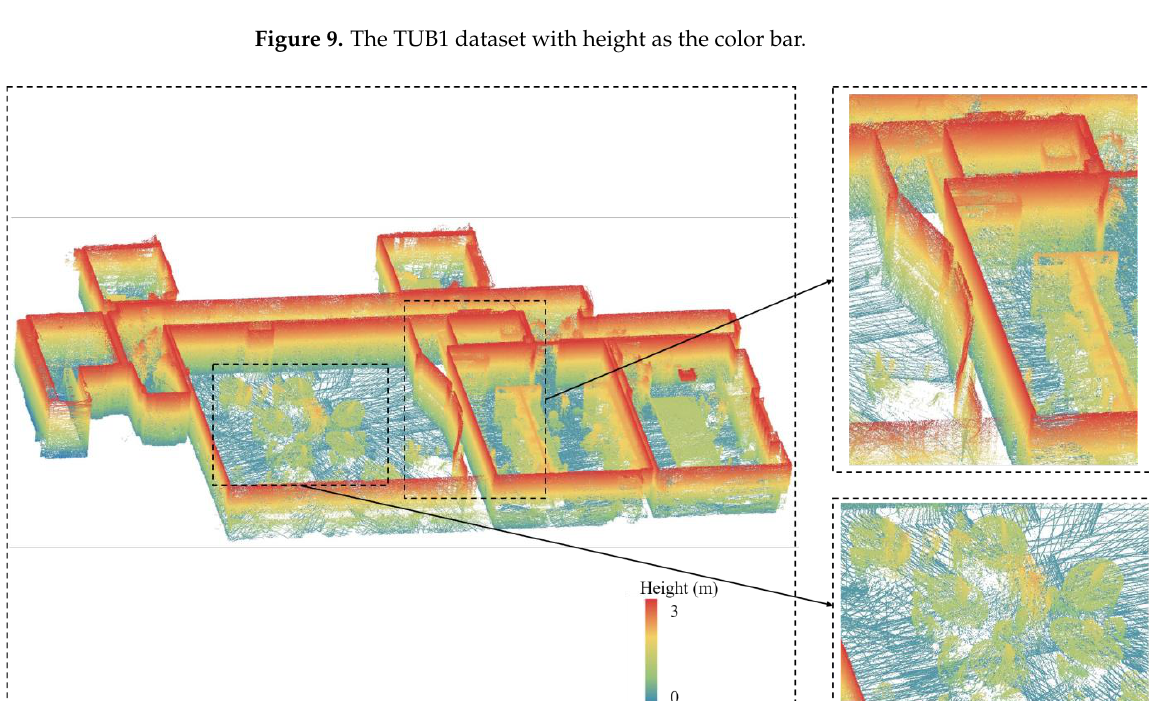
Figure 10. The TUB2 dataset with height as the color bar.